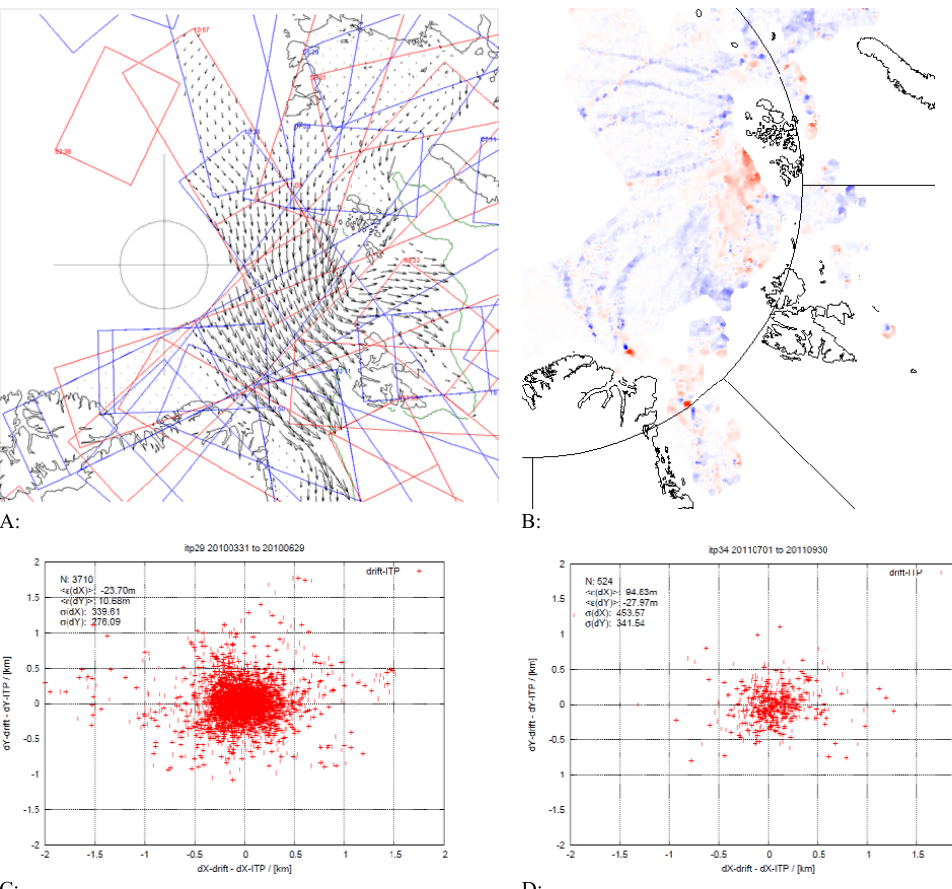
Fig. 10. (A) Example of ice drift derived from ENVISAT ASAR WSM data between 15 March and 16 March 2010. Only every 25th vector shown. Red rectangles show ENVISAT WSM coverage on 15 March, blue on 16 March. (B) Example of corresponding ice deformation pattern derived by differentiating the ice drift field between 15 and 16 March 2010. Blue shows areas of divergence and red areas of conver- gence. (C) Validation of ice ENVISAT ASAR derived ice drift against hourly GPS locations from Ice Tethered Platforms (spring). Axes are difference in drift in 24h (in km). (D) Validation of ice ENVISAT ASAR derived ice drift against hourly GPS locations from Ice Tethered Platforms